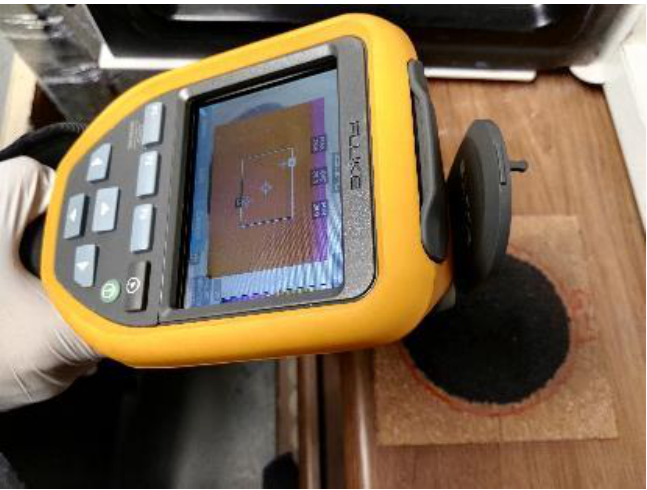
Figure 16. Infrared thermal imager to measure the temperature before and after microwave irradiation.